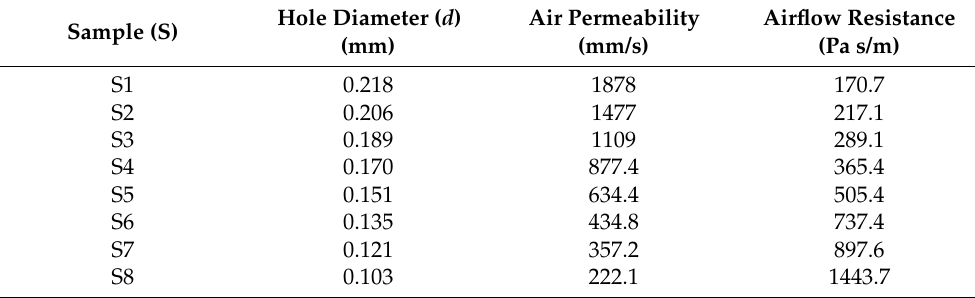
Table 3. Measured air flow resistance of eight woven